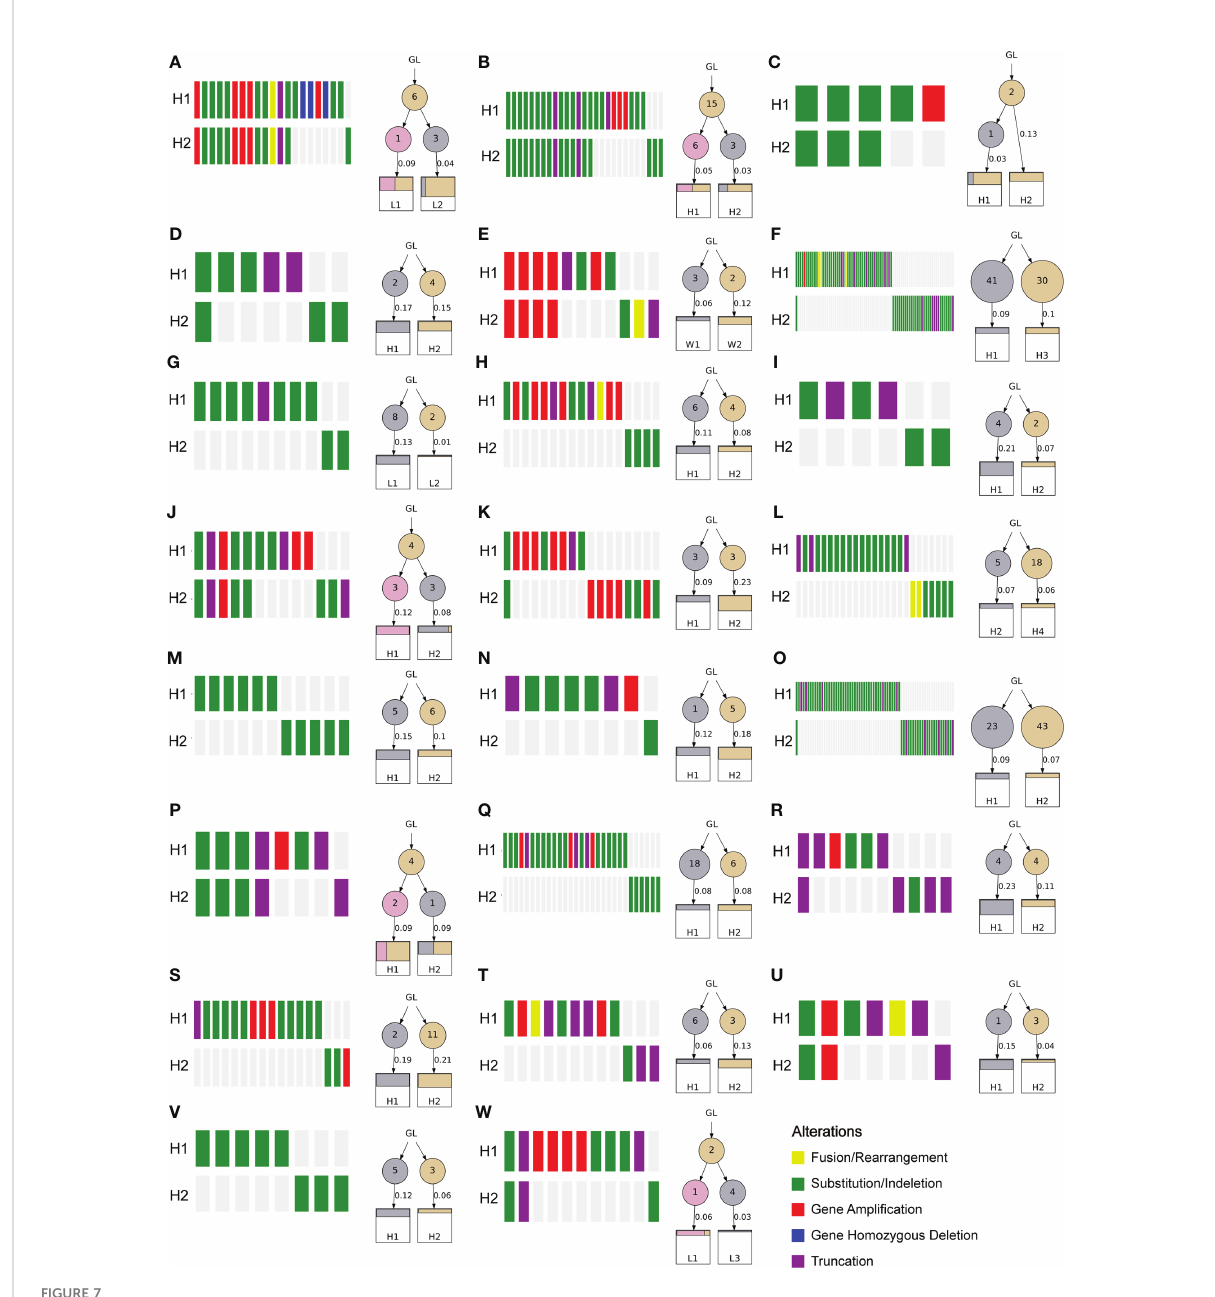
FIGURE 7 Gene alterations and polygenetic tree of the dual-primary LUAD